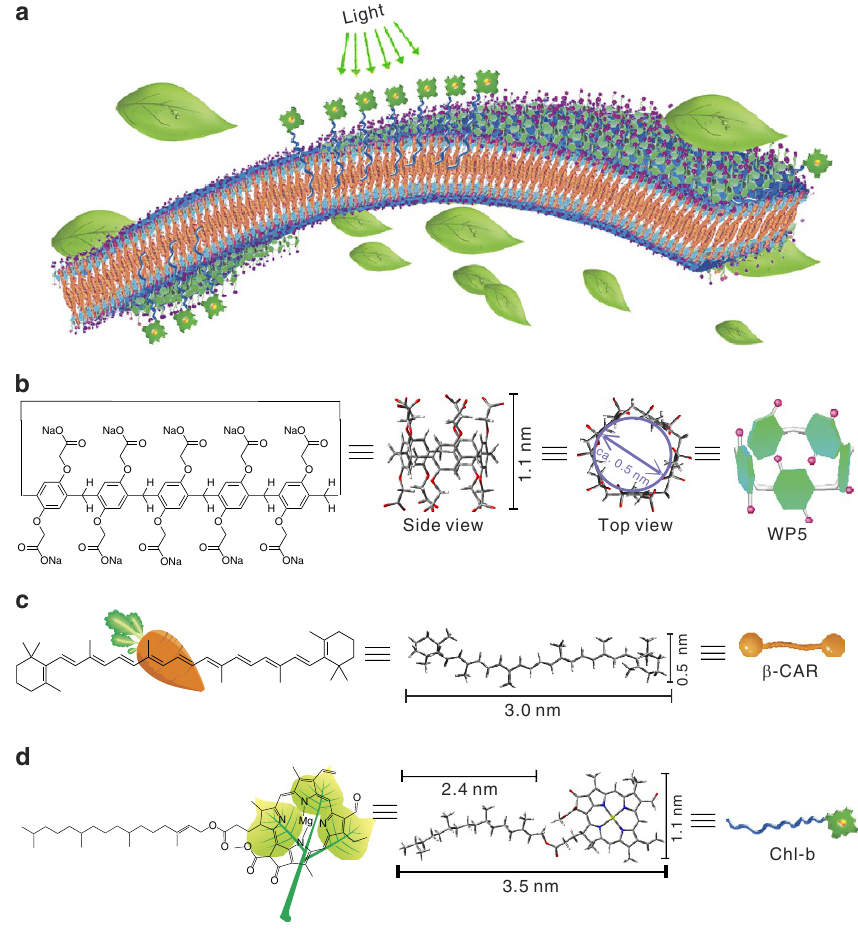
Figure 1 | Structural model of building blocks. ( a ) LHC containing Chl-b formed by ( b ) WP5, ( c ) b -CAR and ( d ) Chl-b. For clarity, the b -CAR-based hydrophobic interior layer is orange, and the WP5-based hydrophilic exterior layer is